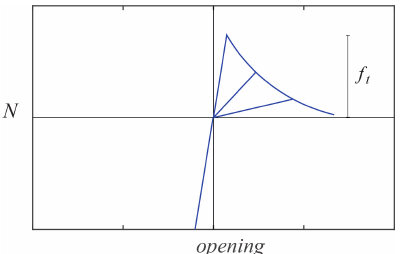
Figure 3. Equivalent frame model of wall-to-wall interface